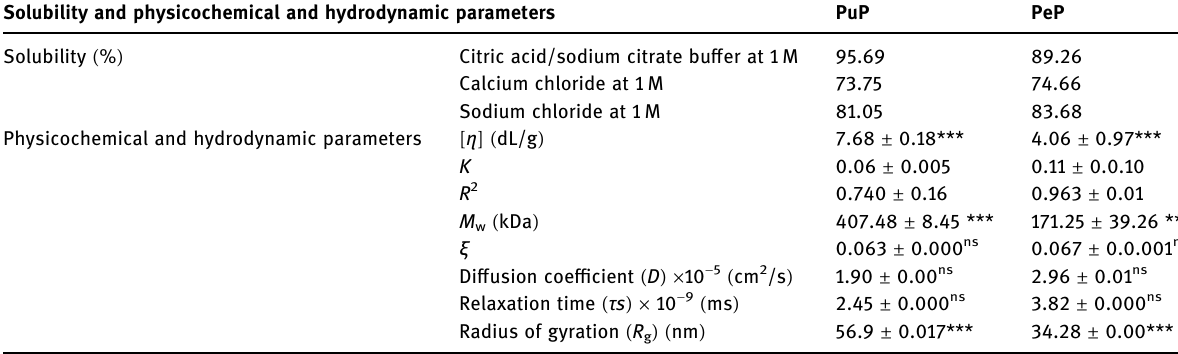
Table 3: Solubility, chemical composition, and molecular parameters of PuP and PeP extracted by water treatment at 80°C and dissolved in 0.2 M citric acid/sodium citrate bu ff er at